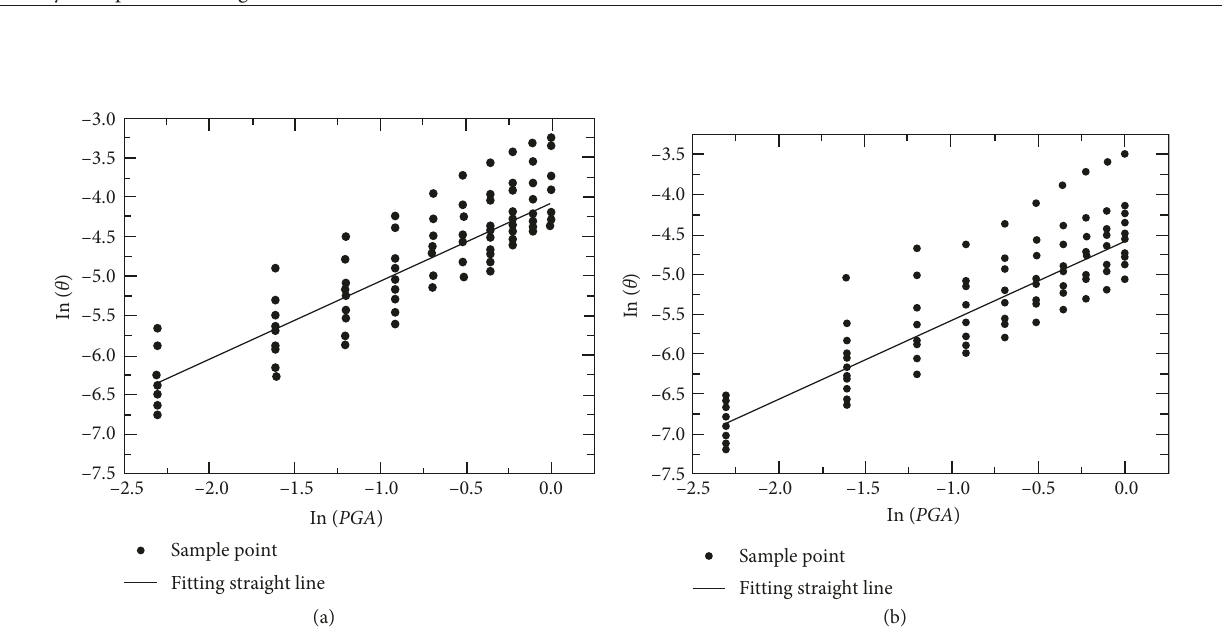
Figure 12: Probabilistic seismic demand regression model: (a) uncontrolled structure; (b) install CARD-VD structure.